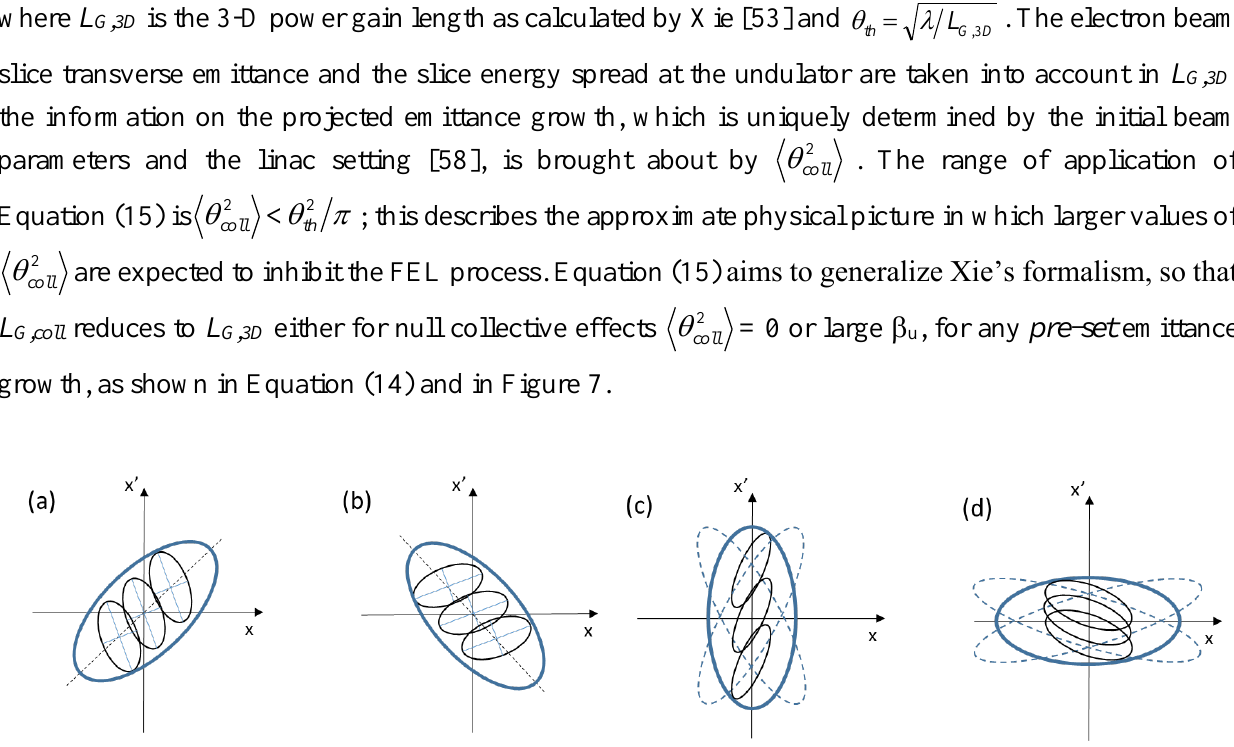
Figure 7. Mechanism of emittance growth in the transverse phase space, due to kicks by collective effects (cartoon). ( a ) Two macro-slices are displaced along the direction of the kick with respect to an unperturbed macro-slice (inner centered ellipse). The projected emittance has grown (outer ellipse). ( b ) Same as in (a), after  /2 betatron phase advance. The area of the outer ellipse remains constant after the kick. ( c ) The beam is matched at the entrance of the undulator to some design Twiss parameters. The optics is smooth in a way that Twiss parameters  and  vary little along the undulator (dashed outer ellipses). Since  u is small, the macro-slices are largely dispersed within the angular divergence corresponding to (solid line ellipse). ( d ) Same as in (c), but with  u large. The macro-slices largely overlap within angular divergence, i.e. , (solid line ellipse). Picture published in [48]. Copyright (2014) by The American Physical